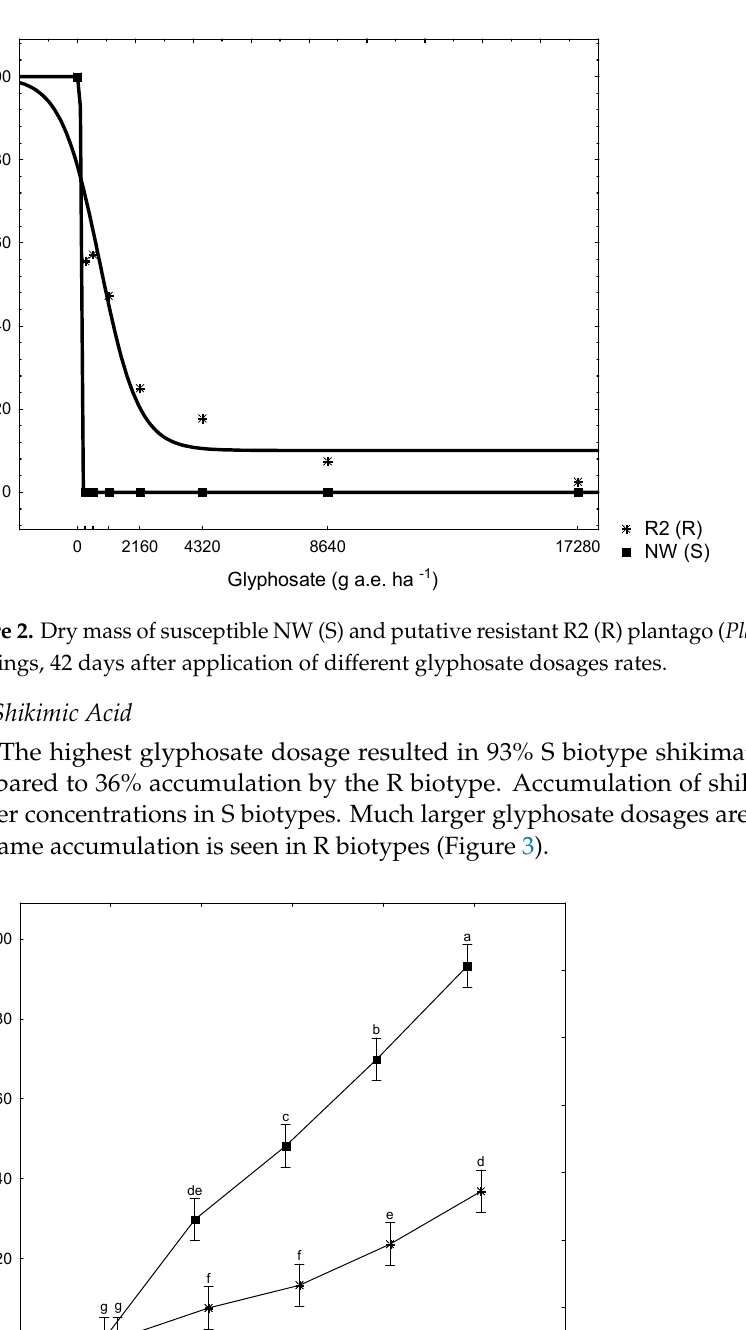
Figure 1. Percentage survival rates of susceptible NW (S) and putative resistant R2 (R) plantago ( Plantago lanceolata L.) biotypes, 42 days after application of different glyphosate dosages rates.